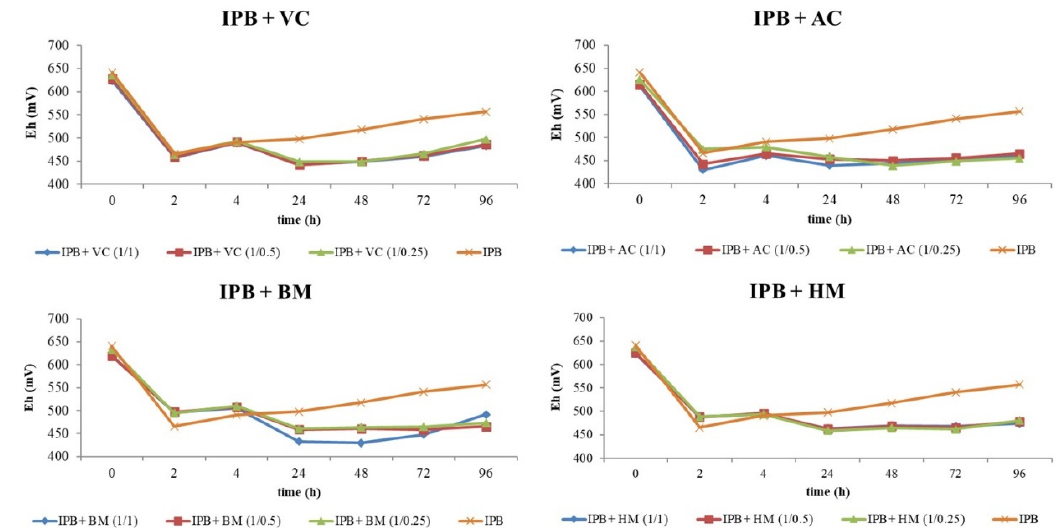
Figure 4. Evolution of Eh (mV) at different reaction times (h).